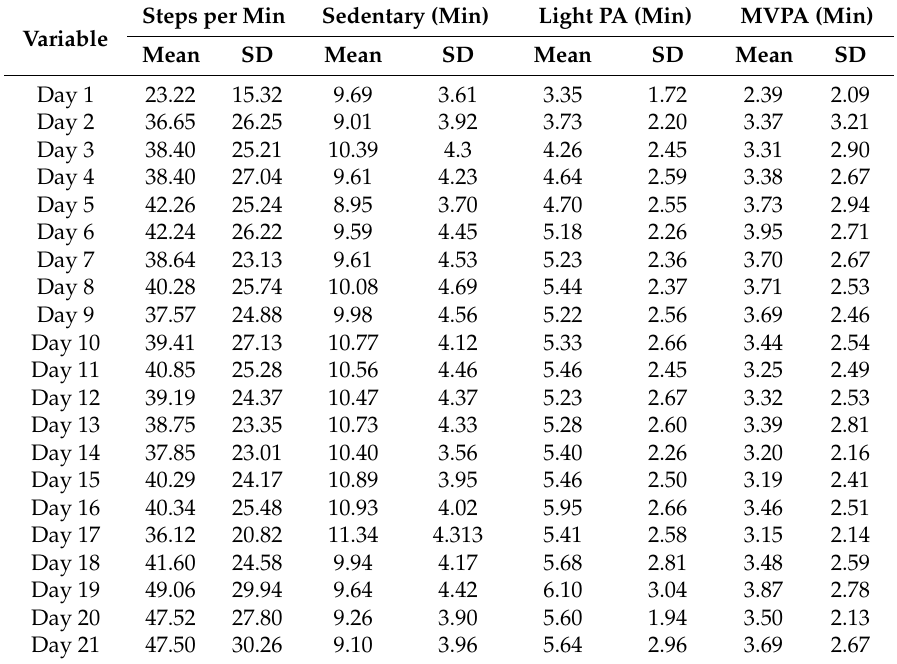
Table 1. Descriptive statistics for all outcome